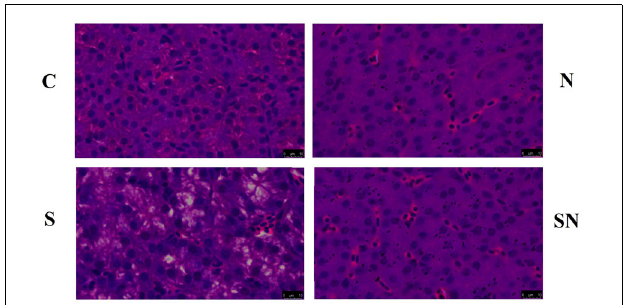
FIGURE 4 | Effect of Fe 3 O 4 -NPs on ROS production in the livers of chickens exposed to Fe 3 O 4 -NPs in the absence or presence of S . Enteritidis administration. Values represent the mean ± SEM. Different letters indicate statistically significant